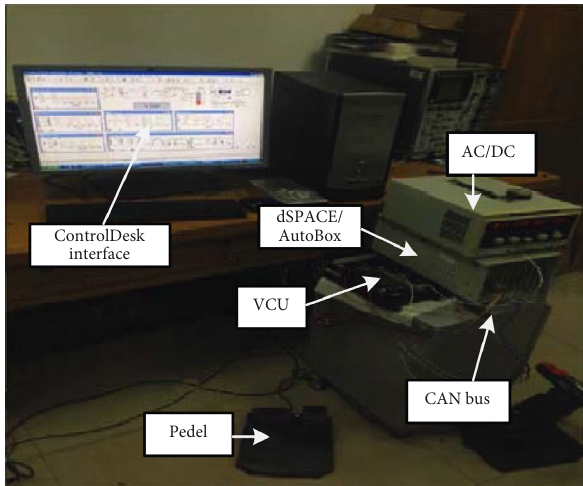
Figure 16: Hardware-in-the-loop test